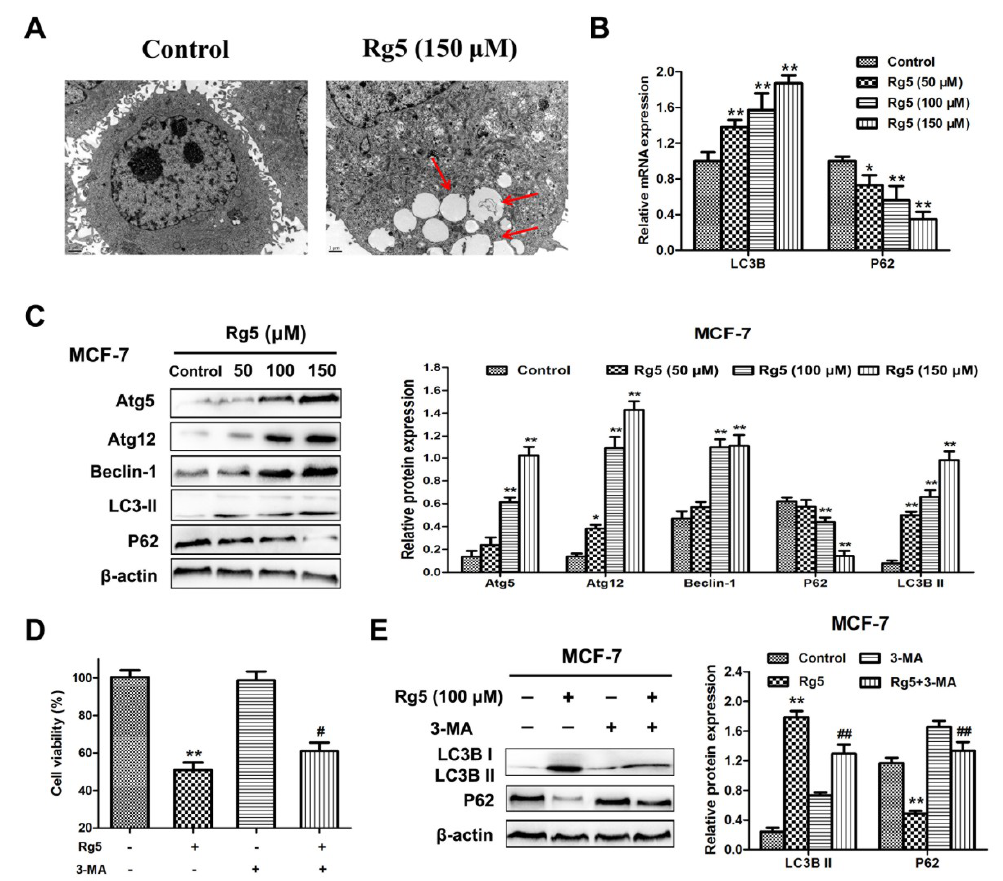
Figure 6. Rg5 triggers autophagy, which leads to cell death. ( A ) Autophagy was detected in MCF-7 cells after Rg5 exposure for 24 h via TEM. Arrows represent autophagosomes. Scale bars = 1 μm. ( B,C ) MCF-7 cells were exposed to Rg5 at different doses for 24 h. ( B ) The relative mRNA expression levels of LC3B and p62 were performed via real-time qRT-PCR. ( C ) Western blotting was performed to evaluate the expression of autophagy-related proteins. ( D,E ) MCF-7 cells were exposed to Rg5 (100 μM) in the presence of 3-MA (2 mM). ( D ) Cell viability was detected via MTT assay. ( E ) Expression levels of the LC3BII and p62 proteins were performed using Western blot analysis. * P < 0.05 and ** P < 0.01 as compared with the control group; # P < 0.05 and ## P < 0.01 as compared with Rg5-trated cells.